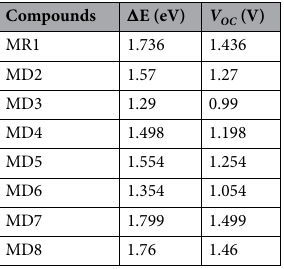
A E D LUMO − HOMO